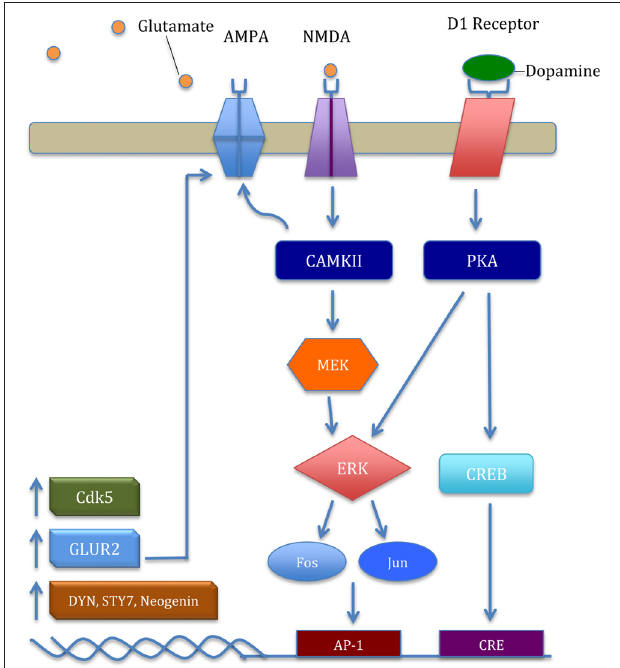
FIGURE 2 | The general mechanism of the extracellular signal-regulated kinase (ERK) pathway and key downstream products important in cocaine addiction. Glutamate binding excites the N-Methyl-D-aspartic acid receptor (NMDAR) and upregulates intracellular calcium. Excitation provokes a signaling cascade, upregulating transcription factors Fos and Jun. Subsequently, increased ∆ FosB acts on activator protein-1 (AP-1) and upregulates transcription and translation of cyclin-dependent kinase 5 (CDK5), GLUR2, dynorphin (Dyn), synaptotagmin VII (Syt7), and neogenin. CDK5 mediates localization and GLUR2-mediated plasticity in α -amino-3-hydroxy-5-methyl-4-isoxazolepropionic acid receptor (AMPAR) through phosphorylation of δ -Catenin (Poore et al., 2010). Increased GLUR2 upregulates the ERK pathway in a positive-feedback type manner through increased AMPAR in the nucleus accumbens (NAcs). Moreover, increased D1 receptor activation upregulates protein kinase A (PKA), phosphorylating the transcription factor cAMP response element binding protein (CREB), leading to further increase in CDK5 and GLUR2 protein levels.